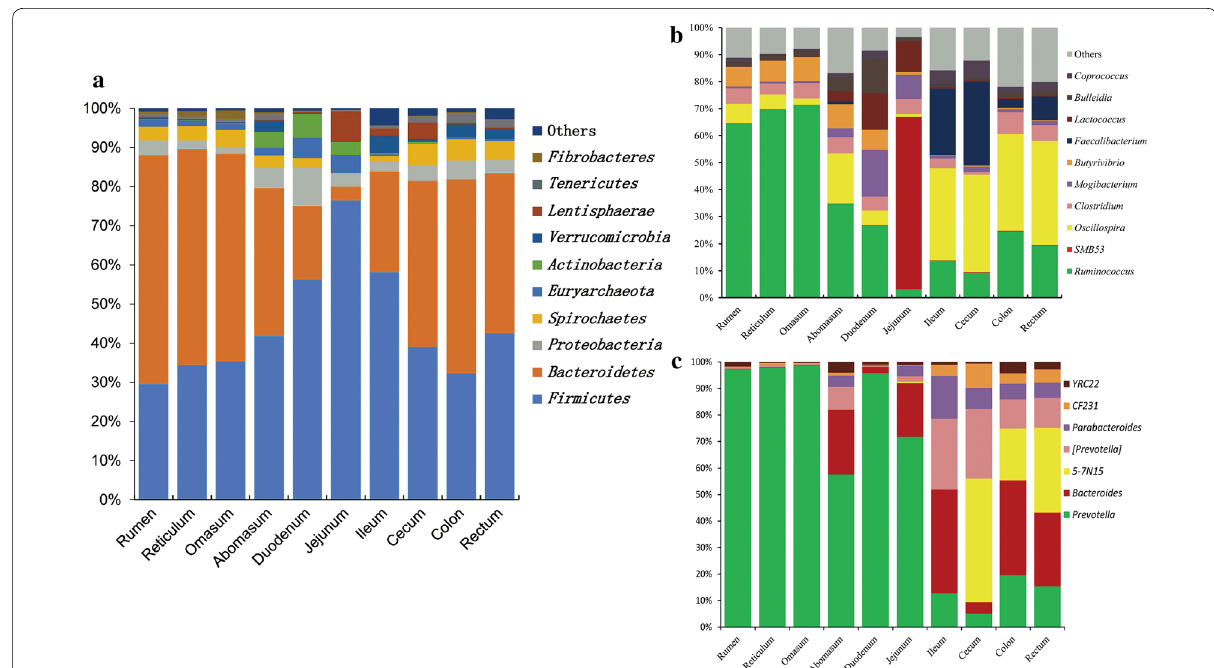
Fig. 3 GIT microbiota at the phylum and genus level. Relative abundance of OTUs at the phylum level in individuals ( a ). Relative abundance of OTUs from Firmicutes ( b ) and Bacteroidetes ( c ) at the genus level in individuals. Only phyla or genera with greater than 1% representation are shown